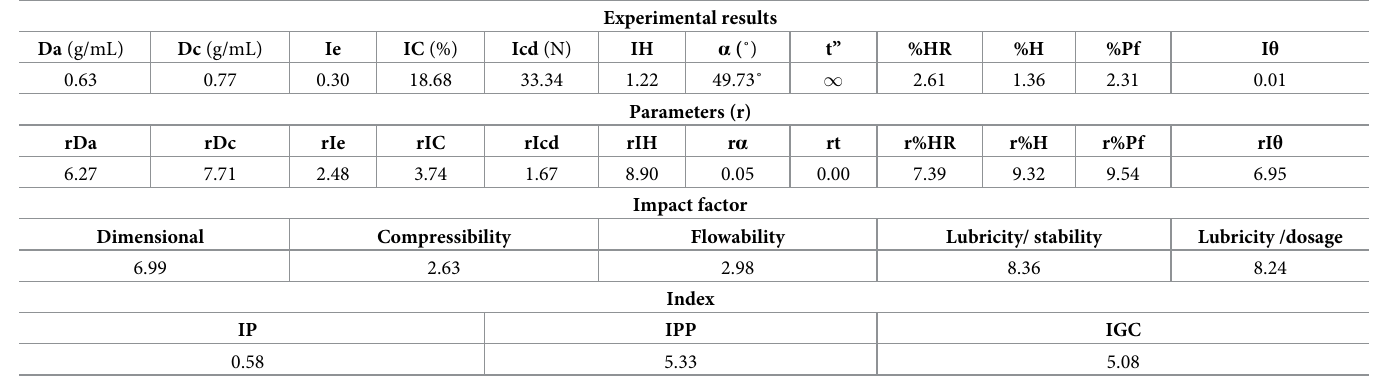
Table 3. Parameters and tests used by the SeDeM method.